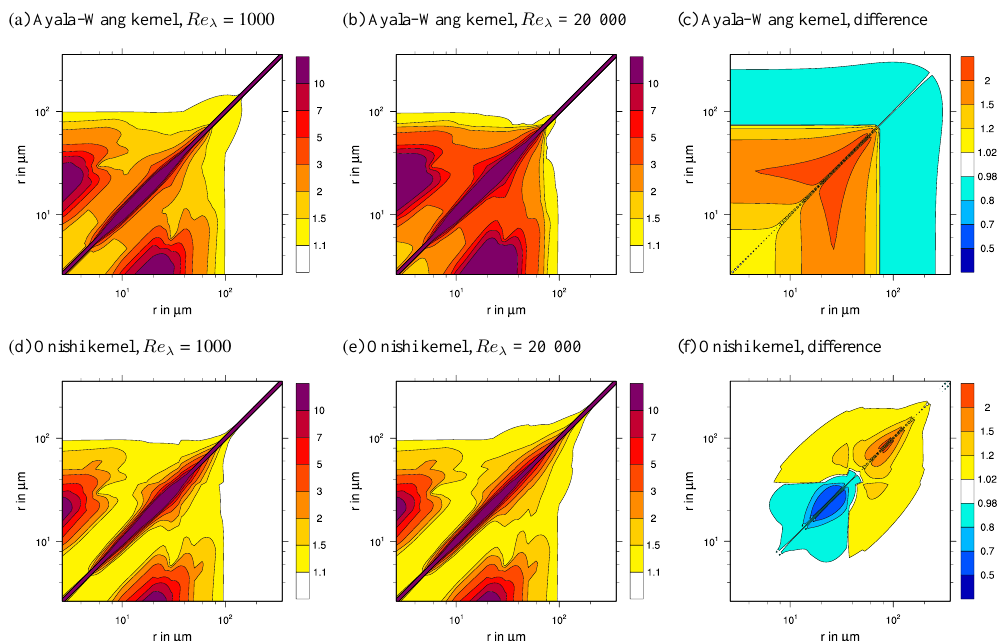
Figure 1. Enhancement factor of the collision–coalescence kernel for a dissipation rate of (cid:15) = 1000cm 2 s − 3 . Shown are (a) the Ayala–Wang kernel for a Taylor-microscale Reynolds number of 1000, (b) the Ayala–Wang kernel for Re λ = 20000, and (c) the ratio of the Ayala–Wang kernel at Re λ = 20000 and Re λ = 1000. The second row shows the same plot for the Onishi kernel at (cid:15) = 1000cm 2 s − 3 and (d) Re λ = 1000 and (e) Re λ = 20000, and (f) the ratio between the kernels at those two Reynolds numbers.